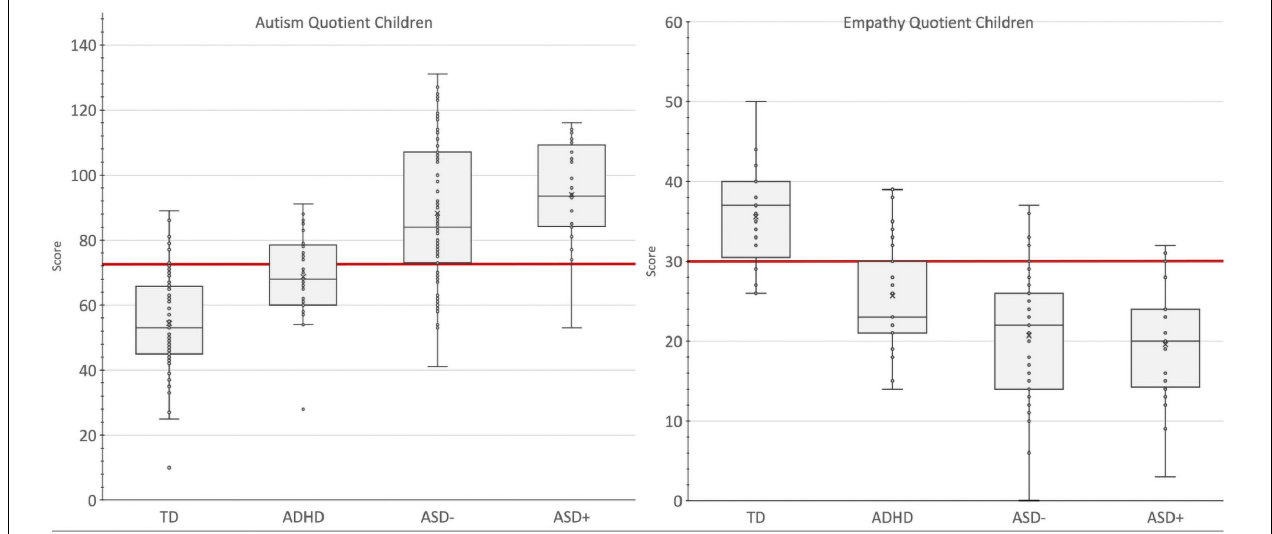
FIGURE 1 | Group comparison on the C-AQ and C-EQ total scores. Box and Whisker Plot. A box is drawn from the first quartile to the third quartile, while a line is drawn at the median and the cross is the mean value. The whiskers extend from each quartile to the minimum or maximum. The Red Line is the Cut-off Value with the Highest Accuracy in Discriminating Autism Spectrum Disorder. TD, Typical Development Group; ADHD, Attention Deficit and Hyperactivity Group; ASD–, Autism Spectrum Disorder Group; ASD+, ASD with comorbid ADHD group.